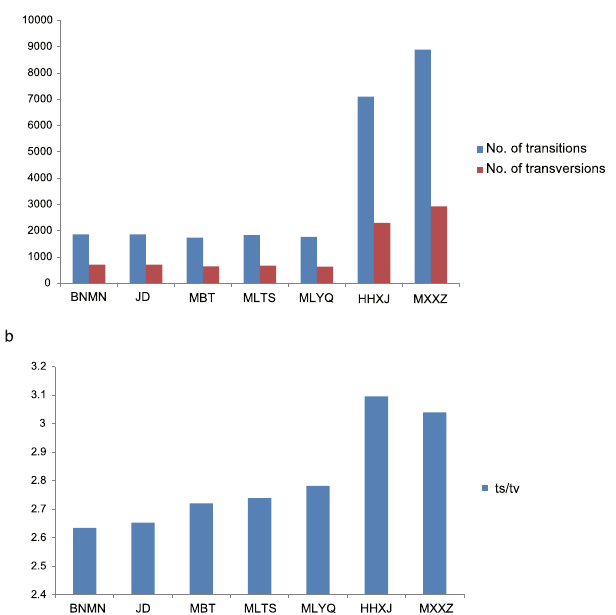
Figure 1. SNP mutation type for the seven populations. ( a ) Number of transitions and transversions for the seven populations. ( b ) Transition/transversion